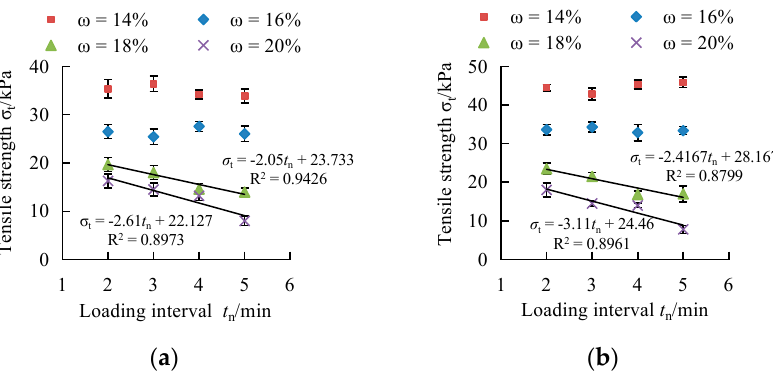
Figure 9. Effect of loading interval on tensile strength: ( a ) ρ d = 1.37 g/cm 3 ; ( b ) ρ d = 1.46 g/cm 3 .